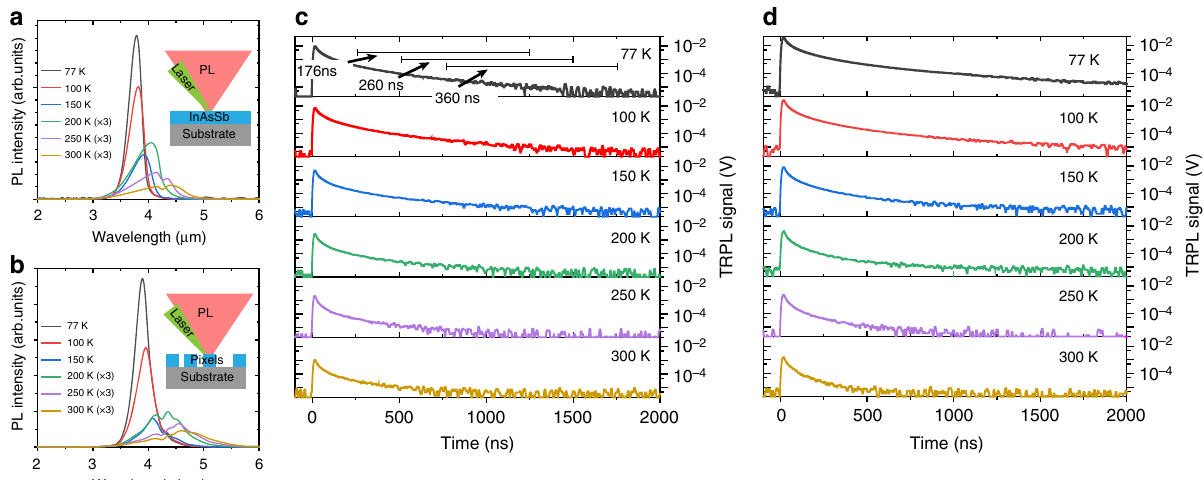
Fig. 2 Optical characterization of the material. Temperature dependence of the photoluminescence (PL) spectra of a bulk, as-grown InAsSb and b a cluster of 24 µ m × 24 μ m, 1 μ m-thick InAsSb pixels placed on thermal release tape. The PL spectra for temperatures greater than 200 K are scaled by a factor of 3 for clarity. Time-resolved photoluminescence (TRPL) data (50,000 averages) from c bulk, as-grown InAsSb and d 24 µ m × 24 μ m, 1 μ m-thick cluster of InAsSb pixels placed on thermal release tape. The 77 K data in c includes lifetimes extracted from shifted fi tting intervals; the signi fi cant variation in extracted lifetimes for these three intervals points to a de fi ciency of the TRPL method. For emitters with weak emission at low injection, the TRPL signal